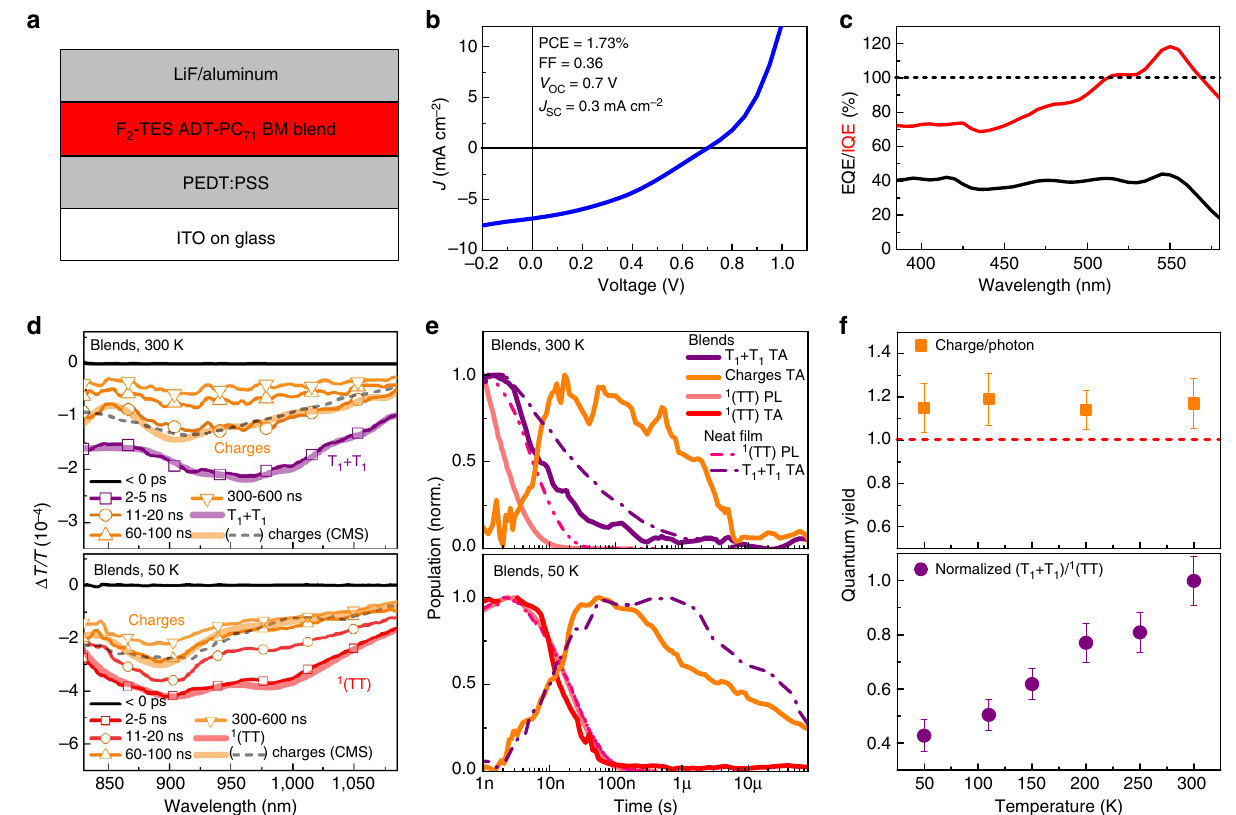
Figure 8 | 1 (TT) in photovoltaic blends. ( a ) Schematic photovoltaic (PV) device structure. ( b ) Typical IV curve for F 2 -TES ADT:PC 71 BM blend PV with corresponding power conversion efficiency (PCE), fill-factor (FF), open-circuit voltage ( V oc ) and short-circuit current ( J sc ) as indicated. ( c ) Despite the low PCE of 1.7%, a plot of external and internal quantum efficiency (external quantum efficiency (EQE) and internal quantum efficiency (IQE) respectively) shows 4 100% IQE in the region where F 2 -TES ADTabsorbs. ( d ) TA spectra of bulk-heterojunction films of F 2 -TES ADTand PC 71 BM in 4:1 molar ratio, at 300K (top) and 50K (bottom) and averaged over the indicated delay ranges (thin lines). Thick lines: species extracted from spectral decomposition. The F 2 -TES ADT hole polaron (radical cation or ‘charge’) spectra extracted through spectral decomposition closely match those obtained with charge- modulation spectroscopy (CMS, dashed). ( e ) Triplet and charge population kinetics extracted from data in ( d ) and Fig. 6. (neat films, dash-dotted) and equivalent transient PL maps. Shortening of both the 1 (TT) PL lifetime and the free triplet lifetime at 300K suggest both species contribute to charge formation. At lower temperatures, no free triplets are detected prior to charge transfer at the interface. The kinetics of interfacial charge transfer closely match those of triplet-pair separation in neat films (dash-dotted). ( f ) Top panel: photon-to-charge conversion yield determined from TA measurements (errors from uncertainty in amplitude of TA signal and charge cross-section) of blend films reveals negligible temperature dependence. In contrast, the yield of free triplets in neat films (bottom panel, error bars reflect noise in raw TA signal), plotted as a ratio of T 1 þ T 1 to 1 (TT) from TA measurements and normalized to the 300K value, varies with stage. Unless otherwise noted, pump intensities were kept below 5 m Jcm (cid:3) 2 to Aldrich. F 2 -TES ADT and TIPS-pentacene thin film samples were spin-cast (15mgml (cid:3) 1 , toluene) on polyimide precoated fused-silica substrates (the avoid bimolecular singlet–singlet annihilation effects and the pump and probe polarization were set to magic angle (54.7 (cid:2) ) to avoid reorientation effects. For ns- polyimide aids wetting of the organic semiconductor). For F 2 -TES ADT: PC 71 BM TA measurements, pump pulses were generated using a frequency-doubled Q - thin film samples, 4:1F 2 -TES ADT:PC 71 BM blend solutions (15mgml (cid:3) 1 total material, mesitylene) were spin-cast on polyimide precoated fused-silica substrates. Samples were dried on a hot-plate at 50 (cid:2) C for 10min. Tetracene, rubrene and pentacene thin-film samples were prepared via thermal evaporation at a base pressure of o 6 (cid:2) 10 (cid:3) 6 mbar. Single crystals of F 2 -ADT were grown through a physical vapour growth method. Details of the relevant method can be seen elsewhere 69 . We used a growth apparatus equipped with source and growth heaters that were placed side-by-side. Temperatures of the heaters were regulated in such a way that high-quality single crystals could be produced. In the present studies we set the source and growth heaters at 240 (cid:2) C and 220 (cid:2) C, respectively. The growth duration was 6h. TA and PL . For TA measurements, 90fs pulses generated in a Ti:sapphire amplifier system (Spectra-Physics Solstice) operating at 1kHz were used. The broadband probe beams were generated in separate home-built non-collinear optical parametric amplifiers for visible (500–800nm) and near-infrared (800–1,100nm) ranges. For fs-ps TA measurements, we used either narrowband o 200fs pulses Triplet sensitization . Blends of N -methylfulleropyrolidine (NMFP) and F 2 -TES from a commercial travelling-wave optical parametric amplifier of super- fluorescence (TOPAS) or compressed pulses ( B 40fs, spanning 525–625nm) from ADT in a molar ratio of 4:1 were prepared at a concentration of 1mgml (cid:3) 1 in a home-built non-collinear optical parametric amplifier to excite the samples. The chloroform. The NMFP was excited by the 355nm frequency tripled output of a time delay between pump and probe pulses was controlled by a mechanical delay Q -switched sub-ns Nd:YVO 4 laser. Following intersystem crossing on NMFP,